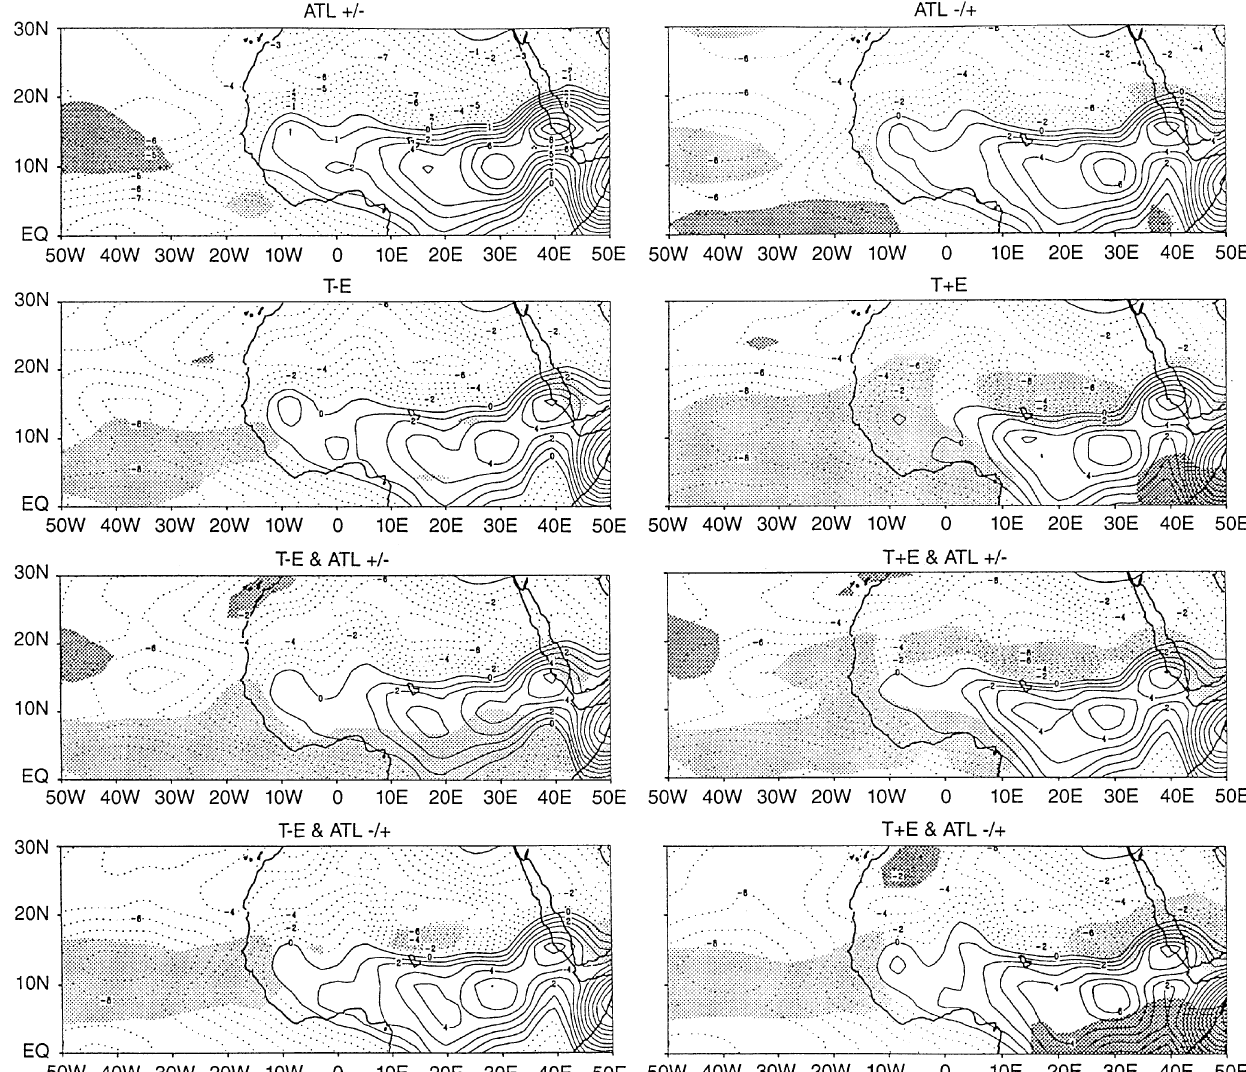
Fig. 7. Zonal wind component at 850 hPa. Positive/negative values in solid ( dotted ) line every 1 m/s. Negative (positive) anomaly areas significant at 5% are shaded in light ( dark )